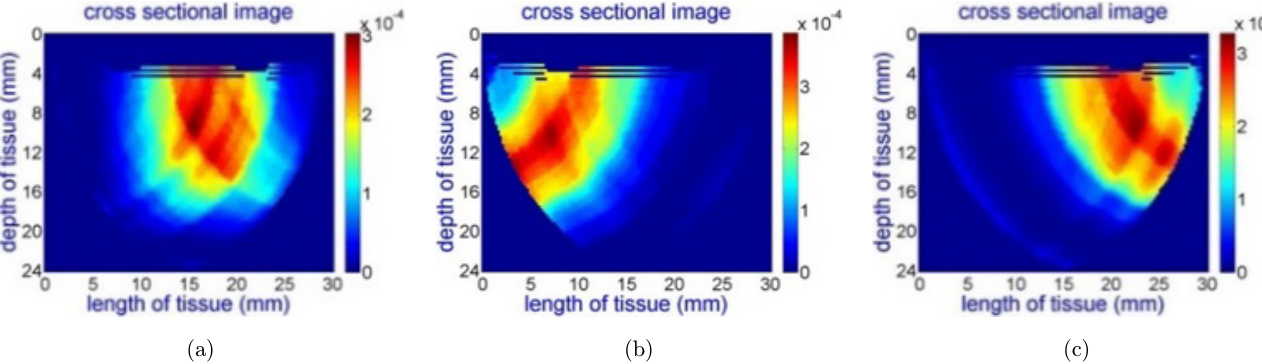
Fig. 7. Reconstructed cross-sectional image for the RBSA phantom for the wavelength of 690 nm while the center line of the probe is aligned: (a) with the center of the hole, (b) 7 mm left to the hole, (c) 7 mm right to the hole for 690 nm light source.